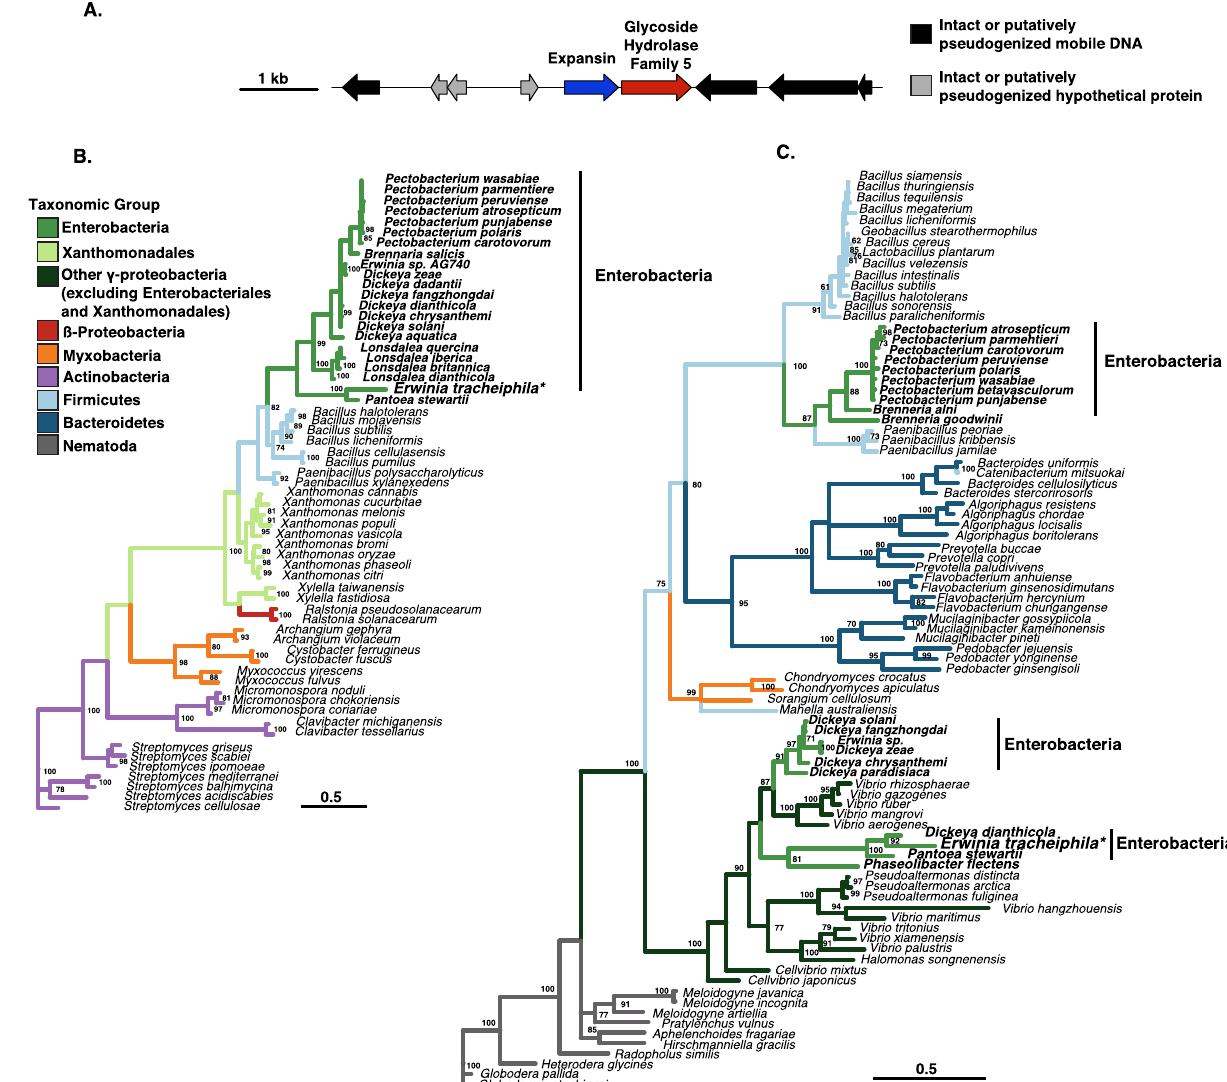
Figure 2. Genomic context and phylogenies of the expansin and glycoside hydrolase 5 genes in Erwinia tracheiphila. ( A ) Genomic context of the expansin ( exlx ) and glycoside hydrolase 5 ( gh5 ) open reading frames (ORFs) in Erwinia tracheiphila. The ORFs and intergenic spaces are drawn to scale, with the black line representing position on the chromosome, and each ORF as an arrow color-coded according to ab initio annotated function. The scale bar is the length in nucleotides of the ORFs and intergenic spaces. ( B ) Distribution of expansin ( exlx ) homologs in a taxonomically representative set of bacterial species. Branches are colored according to taxonomic assignments. The tree was reconstructed using maximum likelihood and should be considered unrooted. Numbers at nodes are bootstrap pseudoreplicates, and the scale bar is the number of amino acid substitutions per site. ( C ) Distribution of glycoside hydrolase 5 ( gh5 ) homologs in a taxonomically representative set of species. Branches are colored according to taxonomic assignments, using the same color assignments as Fig. 1b. The tree was reconstructed using maximum likelihood and should be considered unrooted. Numbers at nodes are bootstrap pseudoreplicates, and the scale bar is the number of amino acid substitutions per